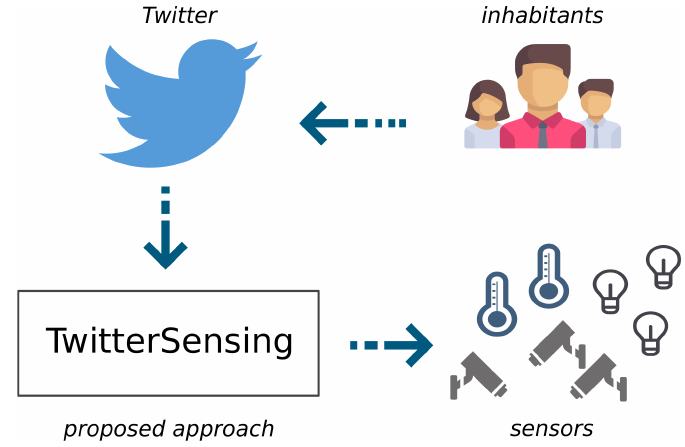
Figure 1. Abstract view of the proposed